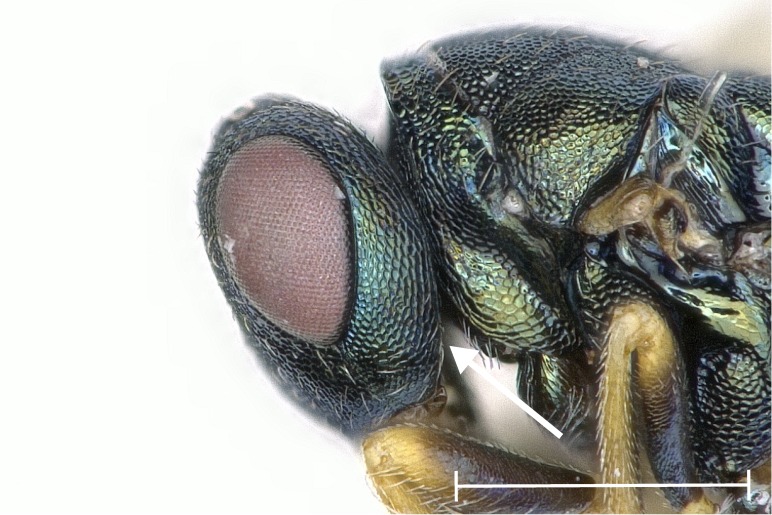
Head, lateral view.